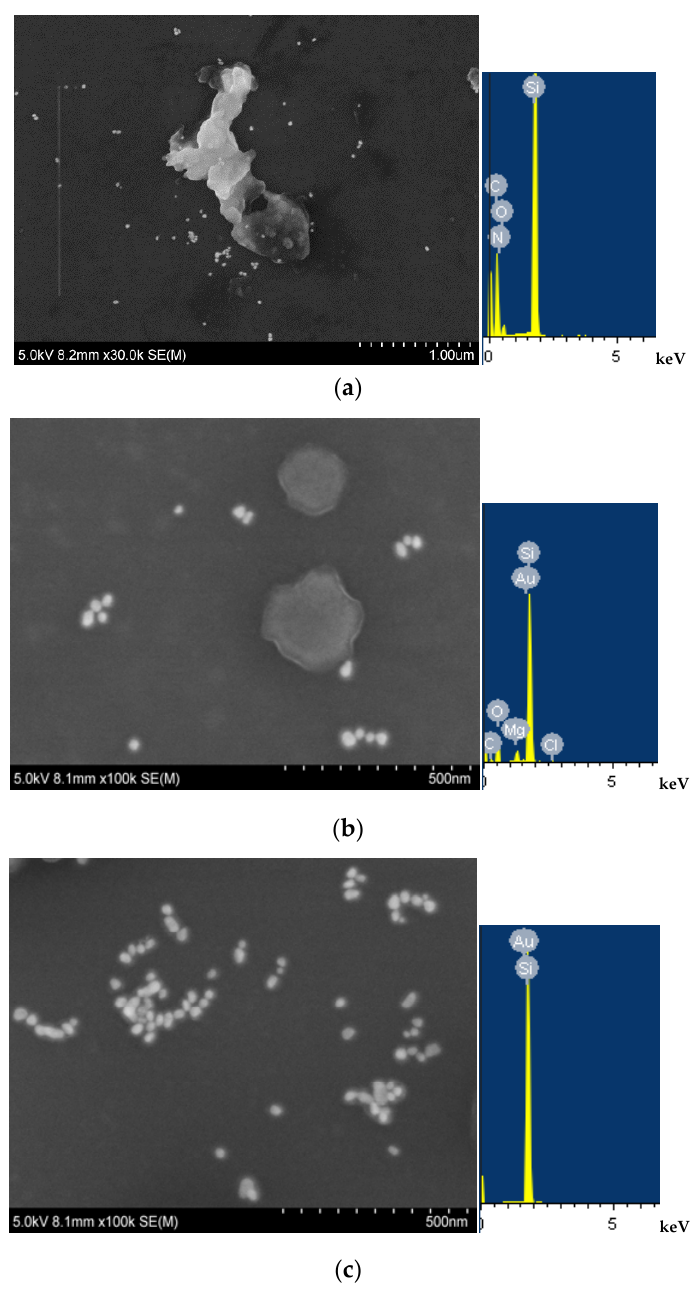
Figure 3. Scanning electron microscopy of the CD 1N analytical system. ( a ): 50 µ g/mL CD 1N ; ( b ): 4.2 µ mol/L HAuCl 4 + 0.33 µ mol/L VB4R + 5 µ g/mL CD 1N + 2.5 mmol/L H 2 O 2 + 53 mol/L BaCl 2 ; ( c ): b + 1.67 µ mol/L Na 2 SO 4 .